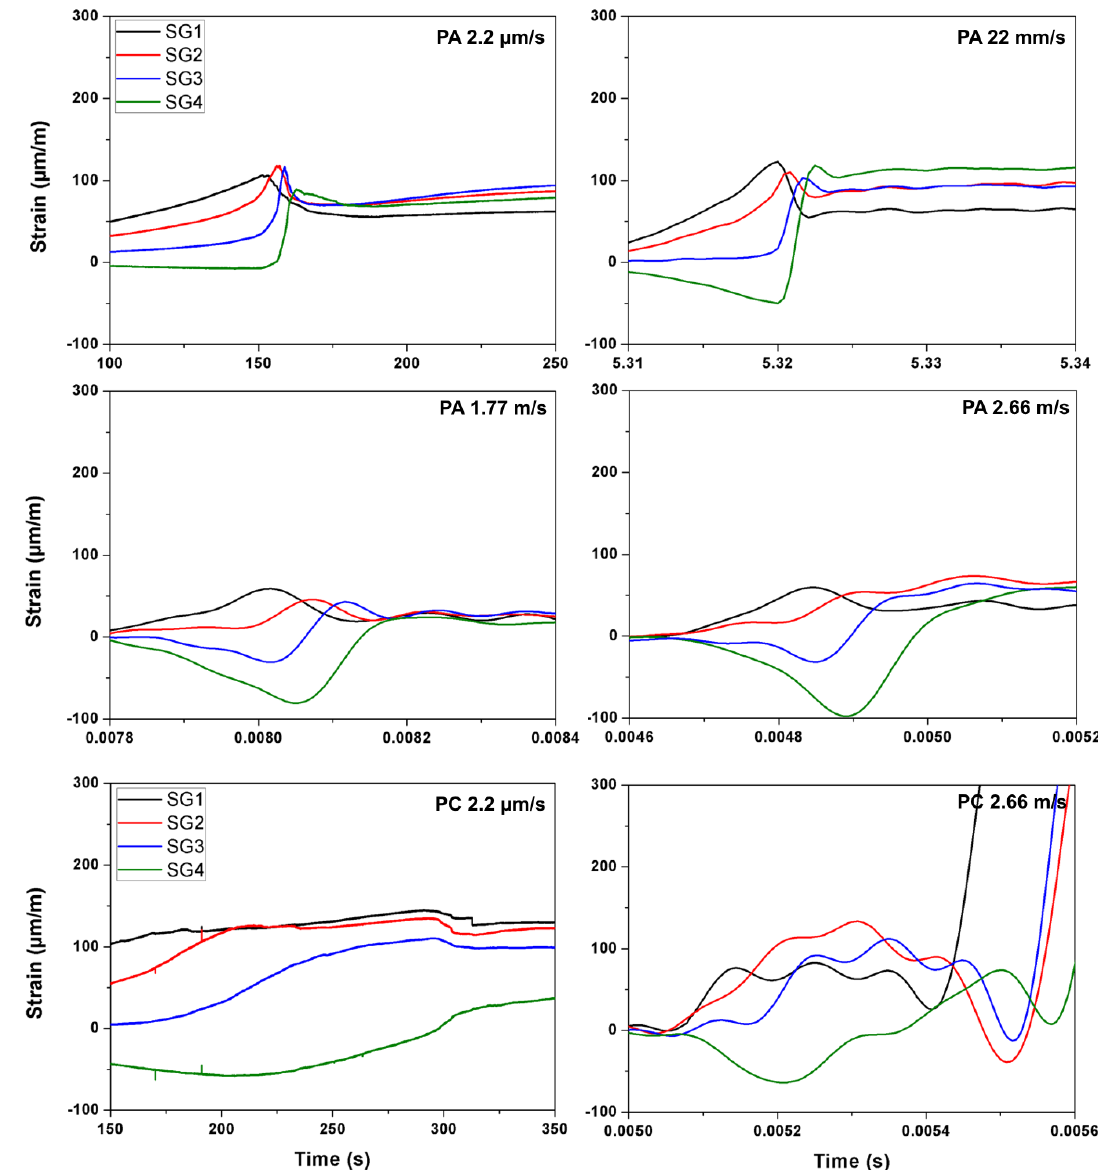
Figure 12. Typical strain histories for concrete PA (at four loading rates) and PC (at the lowest and highest loading rates